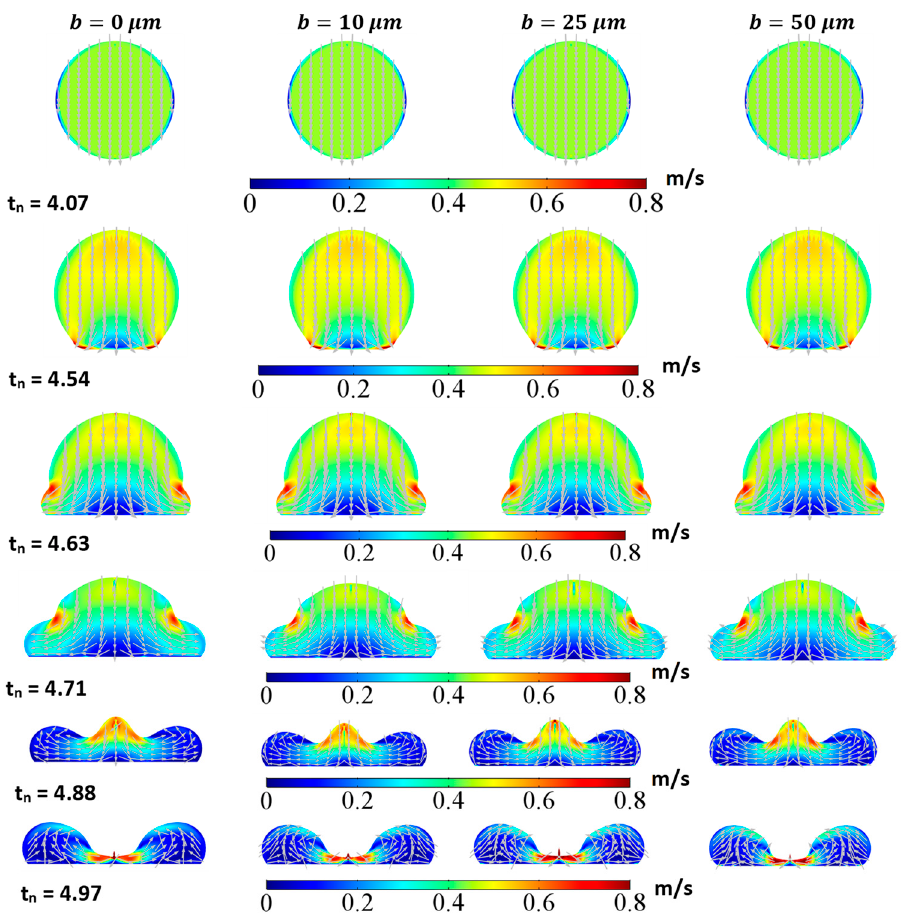
Figure 10. Velocity field developed inside droplet fluid during the spreading period for various micro-post arrays size. Droplet volume is 10 µ L and impact height is 20 mm. The micro-post spacing b = 0 represents the flat hydrophobized surface.